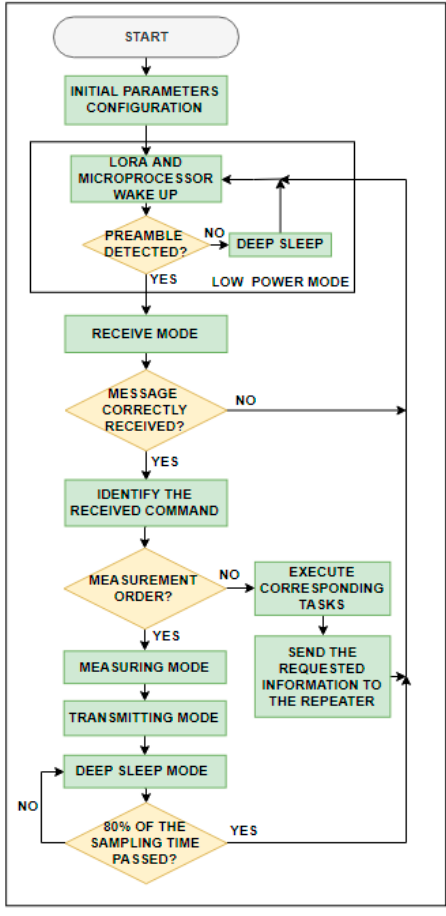
Figure 9. End devices flow chart.